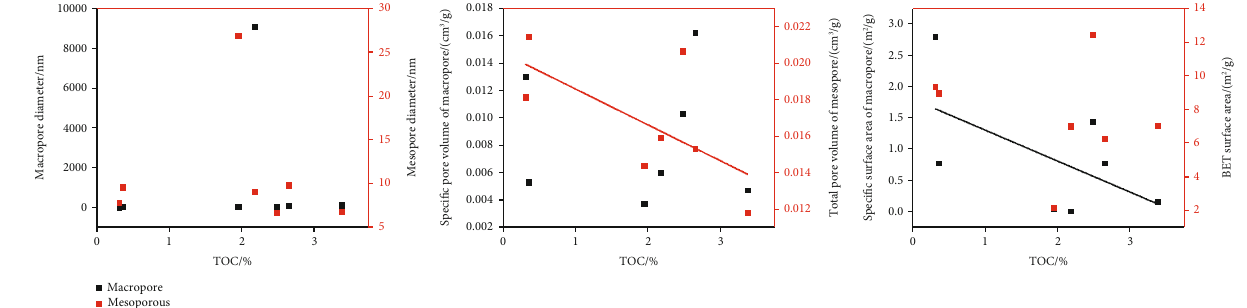
Figure 10: Relationship between geochemical parameters and pore structure parameters of shale